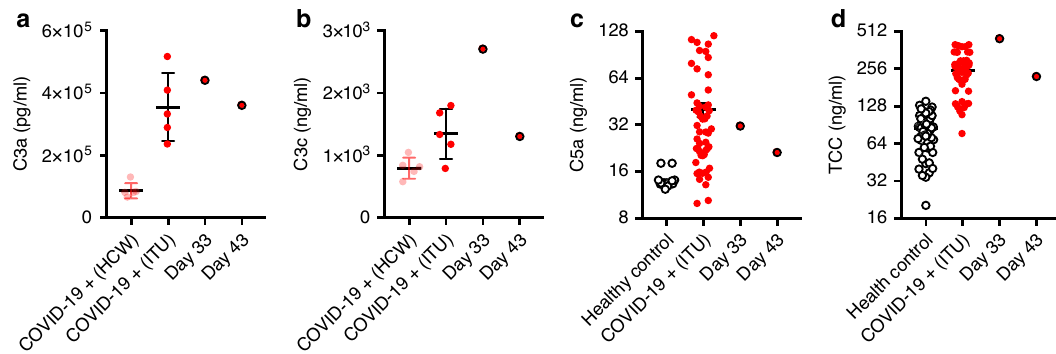
Fig. 4 Assessment of complement activation. Concentrations of complement cleavage products C3a a , C3c b , and C5a c , and circulating terminal complement complex (TCC) d at indicated time points, compared with healthy controls or patients with PCR-con fi rmed COVID-19 (healthcare workers, HCW or patients with severe disease admitted to the intensive therapy unit, ITU; mean and SEM are shown). For a and b HCW, n = 5 biologically independent subjects and ITU n = 5 biologically independent subjects. For c Healthy controls, n = 12 biologically independent subjects and ITU n = 51 biologically independent subjects. d Healthy controls, n = 67 biologically independent subjects and ITU n = 50 biologically independent subjects. Data from one independent